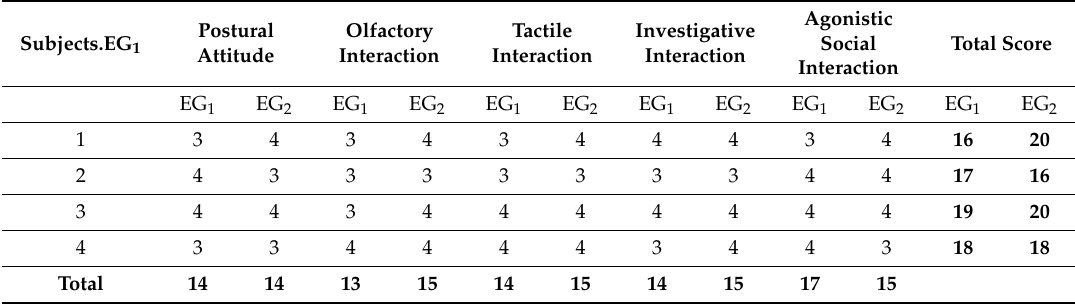
Table 7. Behavioral scores of each donkey in the EG 1 and EG 2 group after observation with patient code F60–F69, F20 (ICD10).